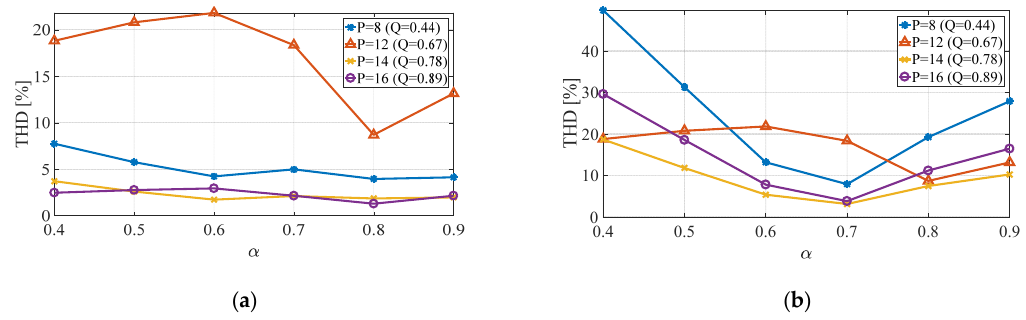
Figure 6. Total Harmonic Distortion (THD) of line to line ( a ) and phase ( b ) back-emf.